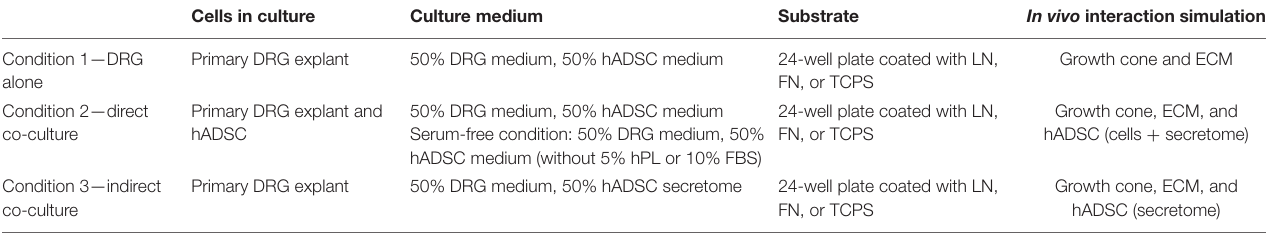
TABLE 1 | DRG explant co-culture in vitro model to mimic the hPL–hADSC therapy on ECM-coated scaffold in vivo